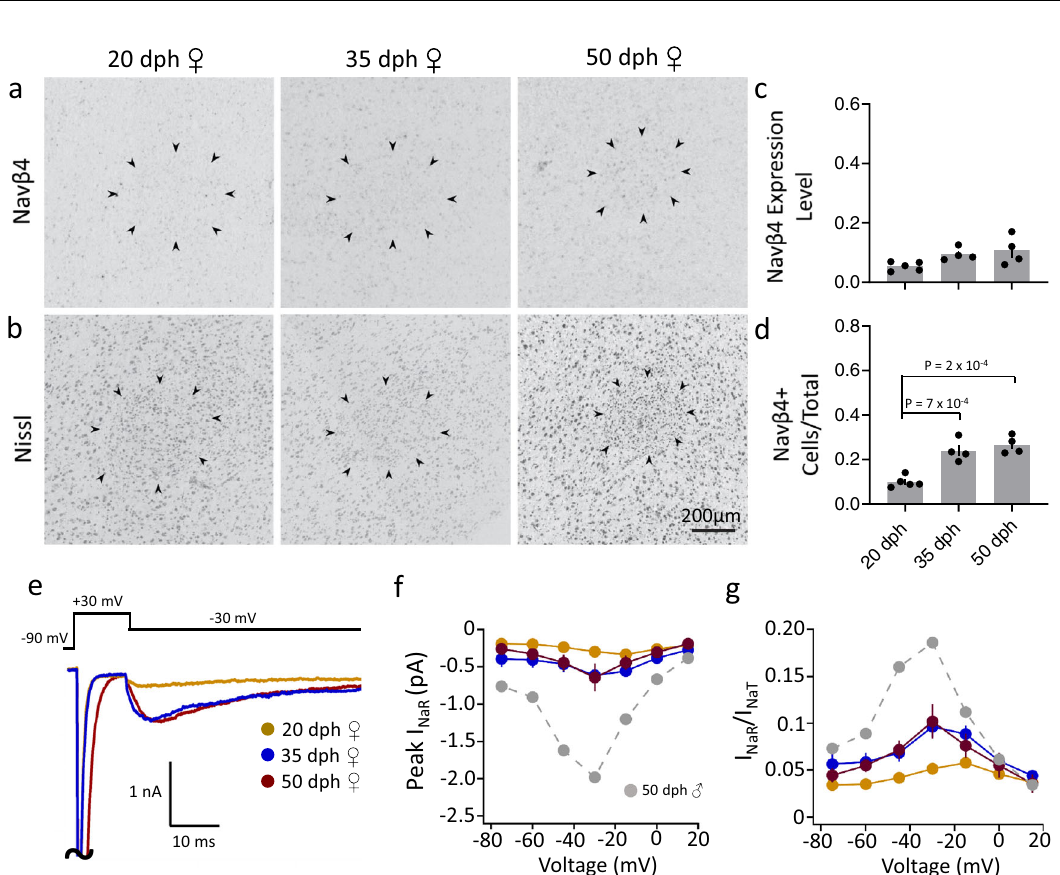
Valuesatthetopofeachpaireddatasetareconductancevaluesusedduringdynamicclamping.ValuesintheOFFcolumnrepresentvaluesobtainedduringa + 300pAcurrentinjectionwithoutdynamic clamping. Values in the ON column represent values obtained during the same current injection with dynamic clamping. For comparisons, a two-tailed paired t test was used for each conductance comparing values obtained before and during dynamic clamping. # APs — the number of APs produced during a 1s + 300 PA current injection, Amp. — AP amplitude, HW — AP half-width, Max. D. — maximum depolarization rate, Max. R. — maximum repolarization rate, Peak — AP peak, AHP — AP afterhyperpolarization peak. N = 5 cells.